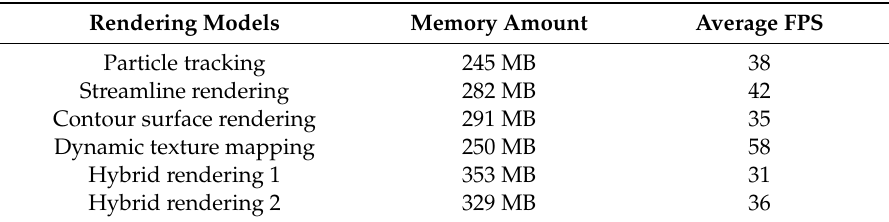
Table 2. The rendering e ffi ciencies of the flow